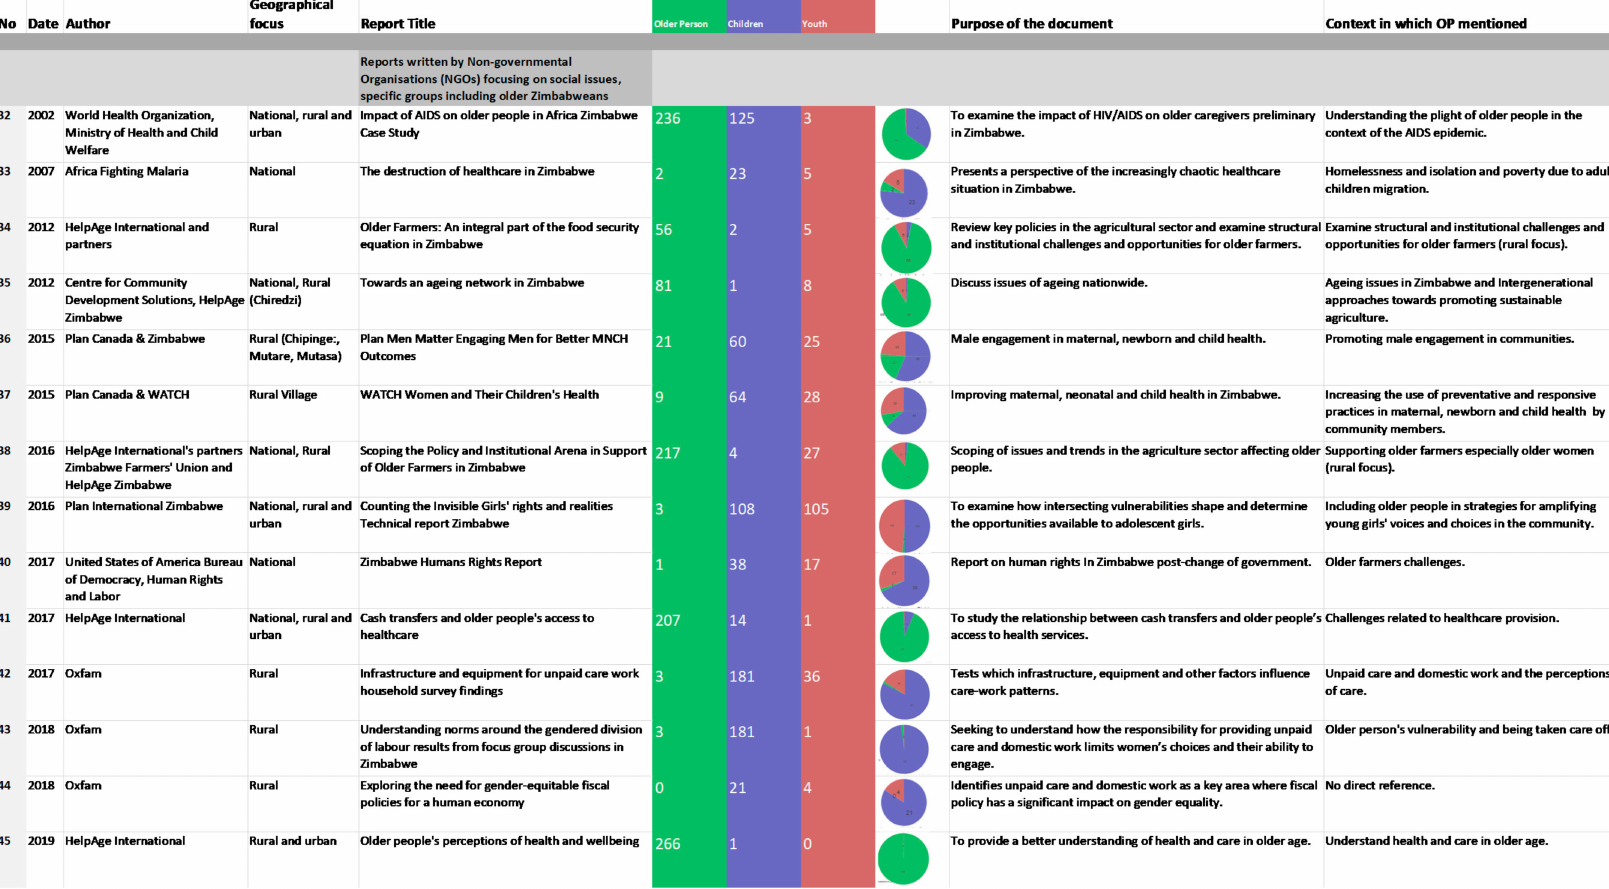
Figure 6. Word frequency and collocation of documents written by Non-Governmental Organisations (NGOs) focusing on social issues, specific groups including older